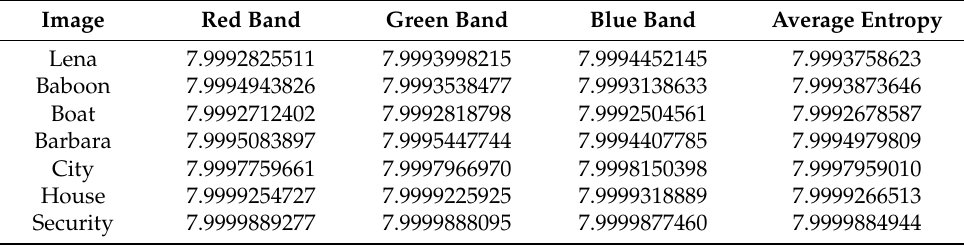
Table 3. Entropy